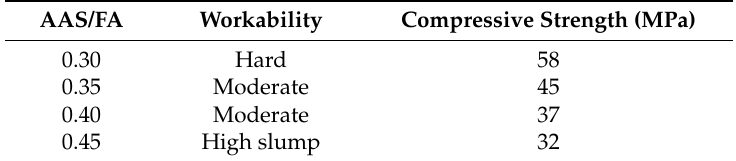
Table 3. Experimental results determining the effect of alkali activated solution to fly ash (AAS/FA) ratio.